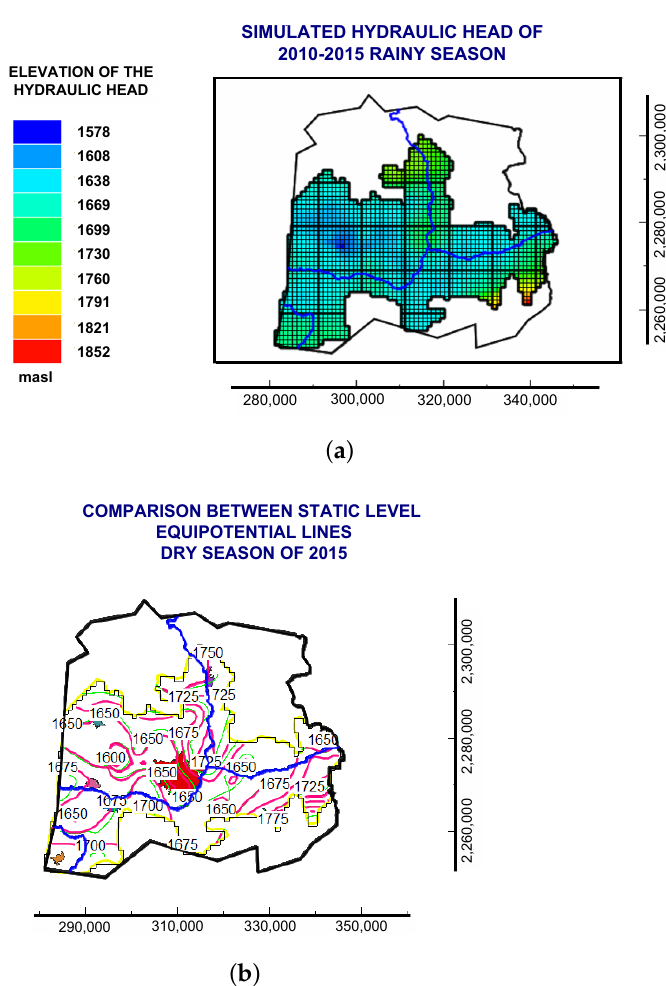
Figura 2.18: Correlaci´on de los niveles piezom´etricos observados y calculados en Temporada de Lluvias, 2015. Figura 2.16: Comparaci´on entre l´ıneas equipotenciales de elevaci´on de nivel est´atico en Temporada de Lluvias, 2015. Figure 14. Dry season. ( a ) Values of hydraulic head in transitory state in the time interval 2010–2015. ( b ) Comparison between static level elevation equipotential lines calculated by the model (pink color) and those measured in the field (green